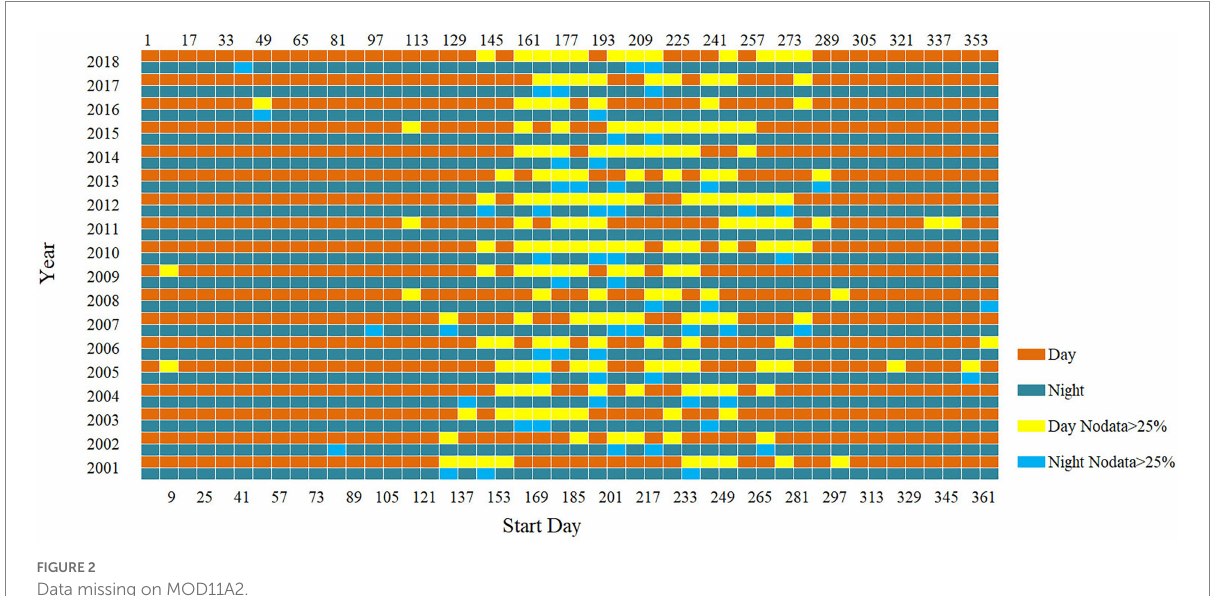
FIGURE 2 Data missing on